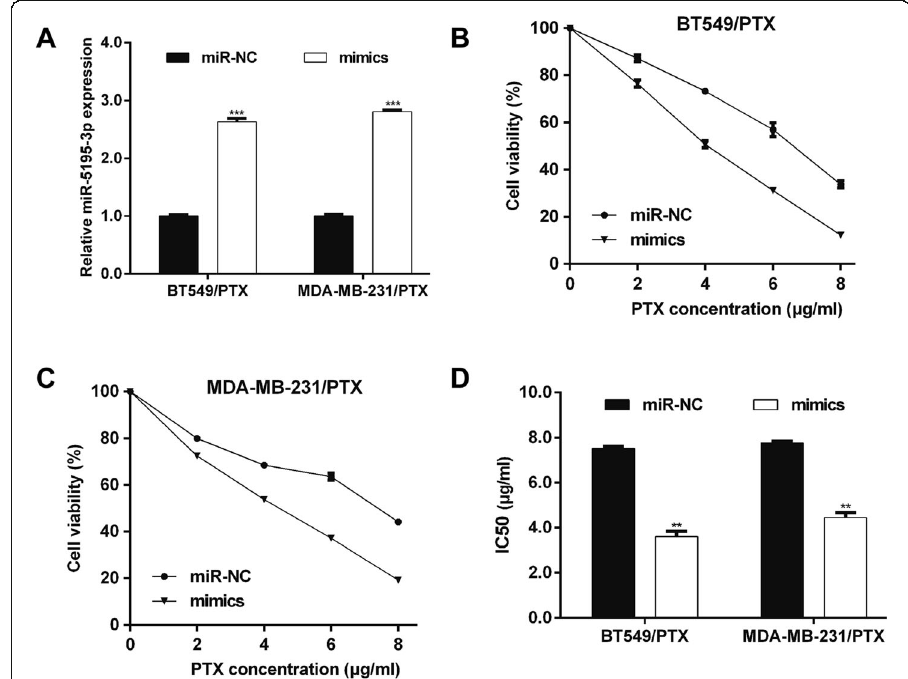
Fig. 2 MiR-5195-3p enhanced the paclitaxel sensitivity of breast cancer cells. a Synthesized miR-5195-3p mimics were transfected into paclitaxel-resistant MCF-7/PTX and MDA-MB-231/PTX cells. MiR-5195-3p expression was measured using quantitative real-time PCR. b and c CCK-8 assay was performed to determine the cell sensitivity to paclitaxel of MCF-7/PTX and MDA-MB-231/PTX cells. d The 50% inhibitory concentration (IC 50 ) value of paclitaxel in MCF-7/PTX and MDA-MB-231/PTX cells transfected with mimics or miR-NC. *** p < 0.001 vs.